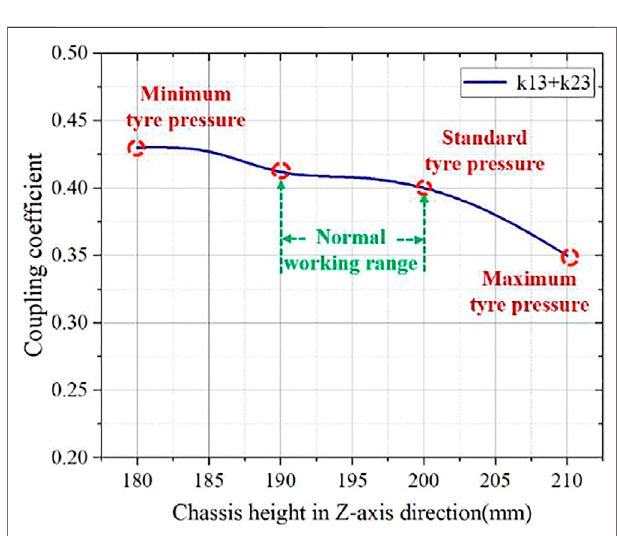
FIGURE 14 | Variation of k with misalignment in the Z